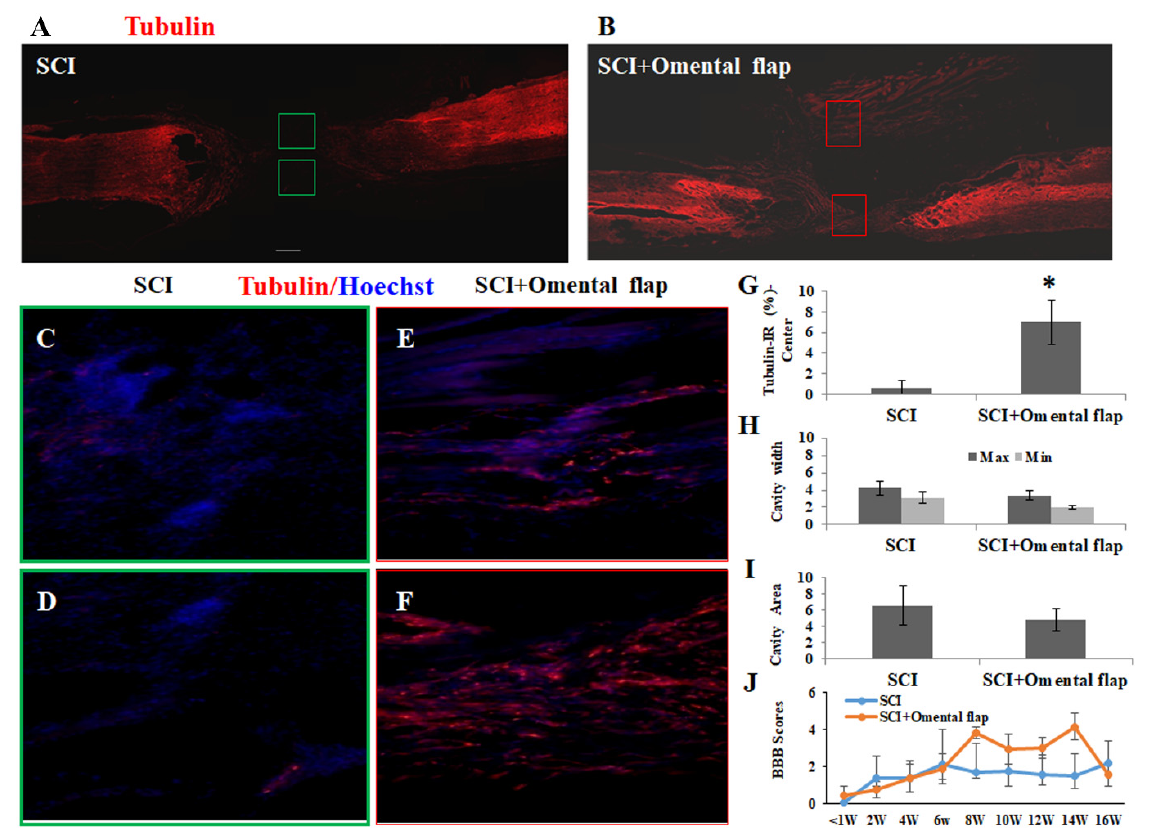
Figure 6. Effect of omental flap on the transected SCI rats. ( A ) Spinal cord section of class III β -tubulin immunoreactivity from transected SCI rats with saline. ( B ) Spinal cord section of class III β -tubulin IR from transected SCI rats with omental flap (magnification_100 × ) at 16 weeks post-treatment. Left: rostral stump; right: caudal stump of the spinal cord. ( C , D ) Class III β -tubulin IR (magnification_200 × ) from the injured epicenter indicated in the green blocked area of the spinal cord in A. ( E , F ) Class III β -tubulin IR (magnification_200 × ) from the injured epicenter indicated in the red blocked area of the spinal cord in B. ( G ) The quantitative results of class III β -tubulin IR in the injured epicenter of transected SCI rats with saline or omental flap treatment. Omentum flap could preserve more class III β -tubulin in transected SCI rats significantly ( p < 0.05). ( H ) The width of lesion cavity in the transected SCI rats with saline or omentum flap. There was no significant difference between the two groups. ( I ) There was no significant difference in cavity area in the transected SCI rats with saline or omentum flap. Cavity width and area was calculated after GFAP staining of the longitudinal spinal cord sections. ( J ) The hindlimb functional behaviors, expressed as BBB scores, in SCI rats with saline or omental flap treatment, 4 rats per groups. The results are reported as mean ± SEM. Statistical significance was evaluated using one-way ANOVA and Bonferroni’s t-test. * p < 0.05.